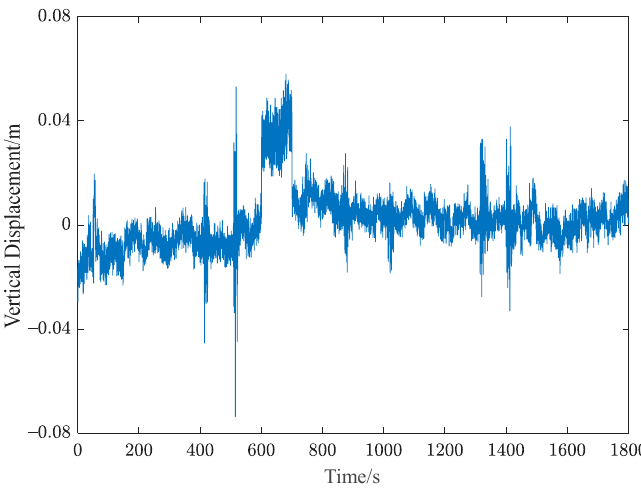
Figure 13. Wilford Bridge vertical displacement of GNSS/accelerometer fusion after adding gross errors. Table 3. Wilford Bridge Statistics of AIME/SRAIME gross error detection